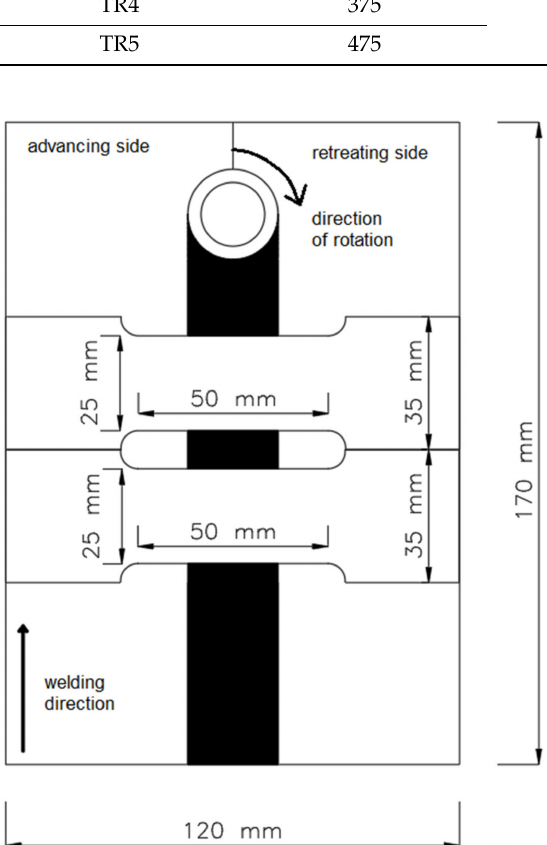
Figure 2. The location of the specimens cut for the tensile strength